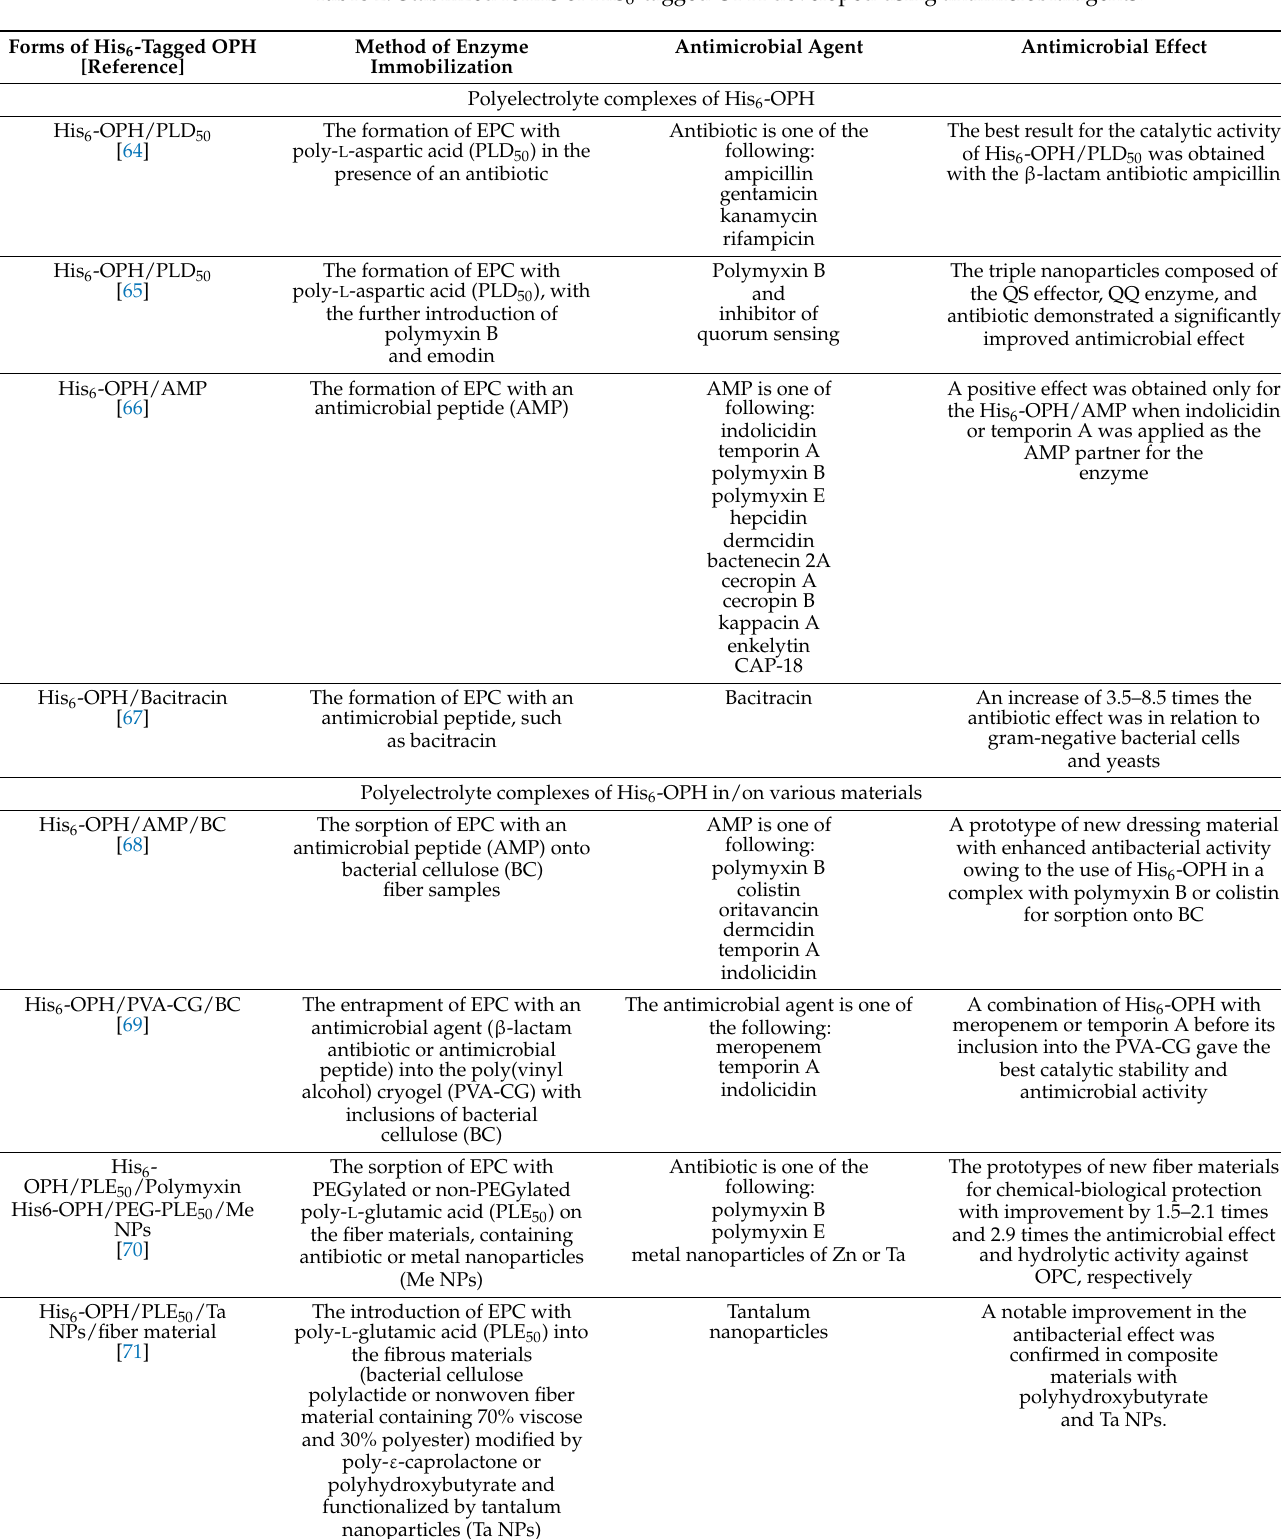
Table 2. Stabilized forms of His 6 -tagged OPH developed using